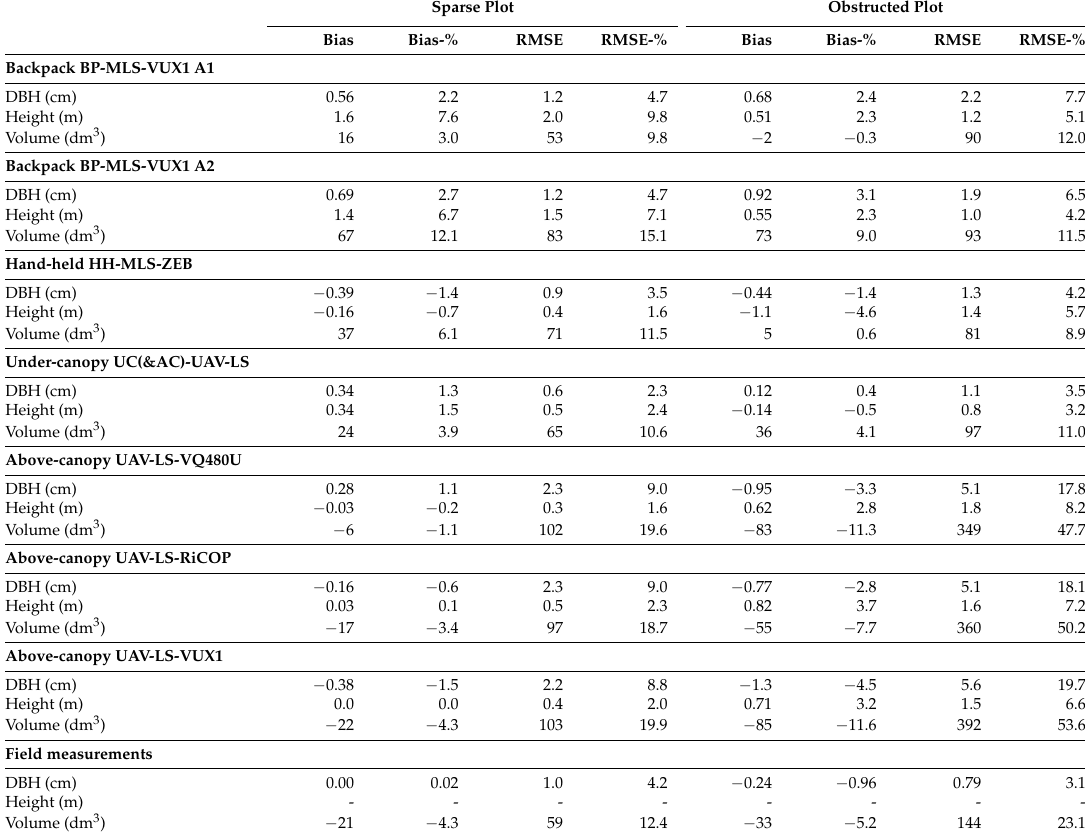
Table 7. The bias and root mean square error (RMSE) of DBH, tree height and stem volume estimation for the detected trees in the two plots based on the different mobile and airborne laser scanning methods. In the case of the under-canopy UAV LS, we have extracted the tree heights used for the stem volume computation from an above-canopy (AC) UAV measurement. In the table, we also compare field-measured DBHs and stem volumes against our reference measurements. The stem volumes of the field measurements were estimated by using the national Finnish allometric model [57] whose inputs are the field-measured DBH, tree height, and tree species. As field measured heights are used as the reference heights, the bias and RMSE of field measured heights is not presented in this table. Note that the units for the bias and RMSE are provided inside parentheses after each tree attribute in the leftmost